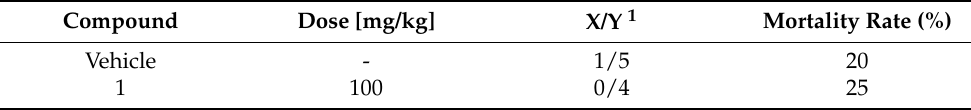
Table 2. Anticonvulsant activity of the compound 1 in MES test.